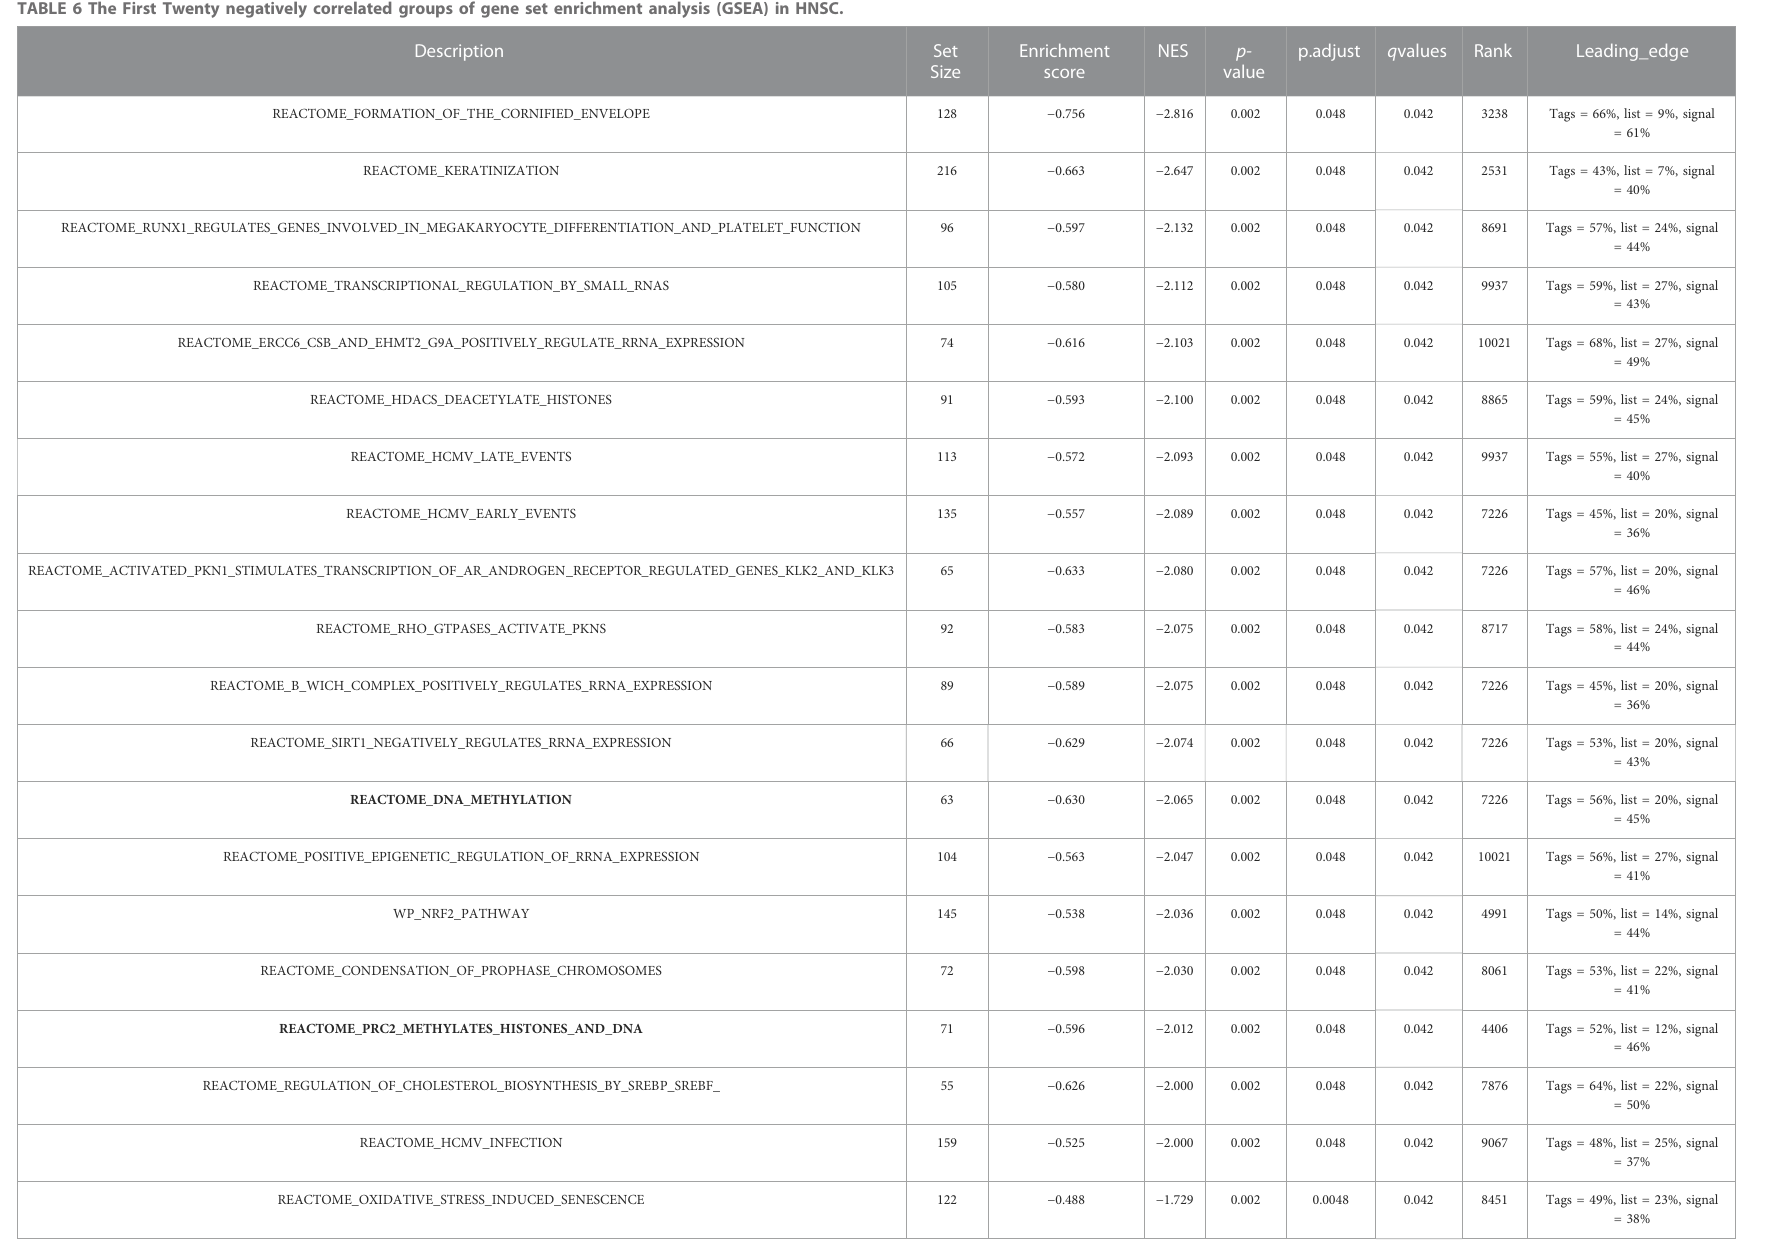
TABLE 6 The First Twenty negatively correlated groups of gene set enrichment analysis (GSEA) in